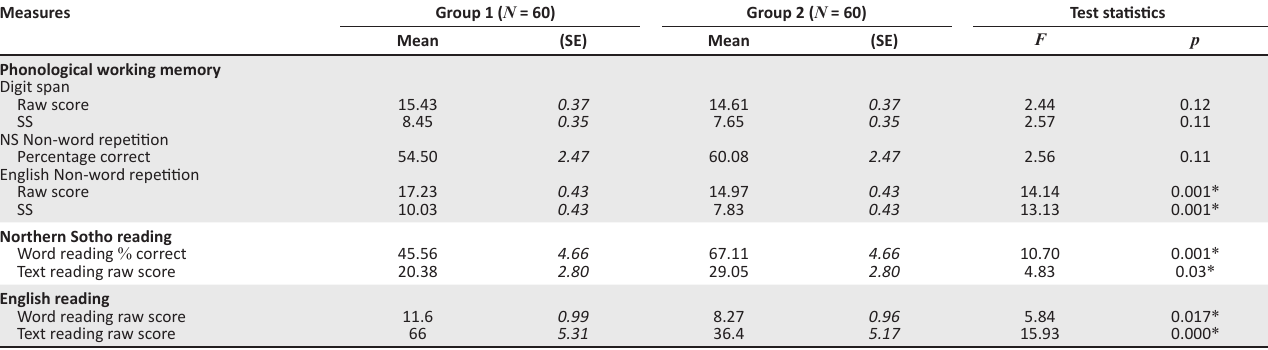
TABLE 2: Mean raw score and SS for Digit span , Mean percentage for Northern Sotho non-word repetition task (NS NRT), Mean raw score and SS score for English NRT , Means for word reading and raw score for fluent reading . Measures Group 1 ( N = 60) Group 2 ( N =